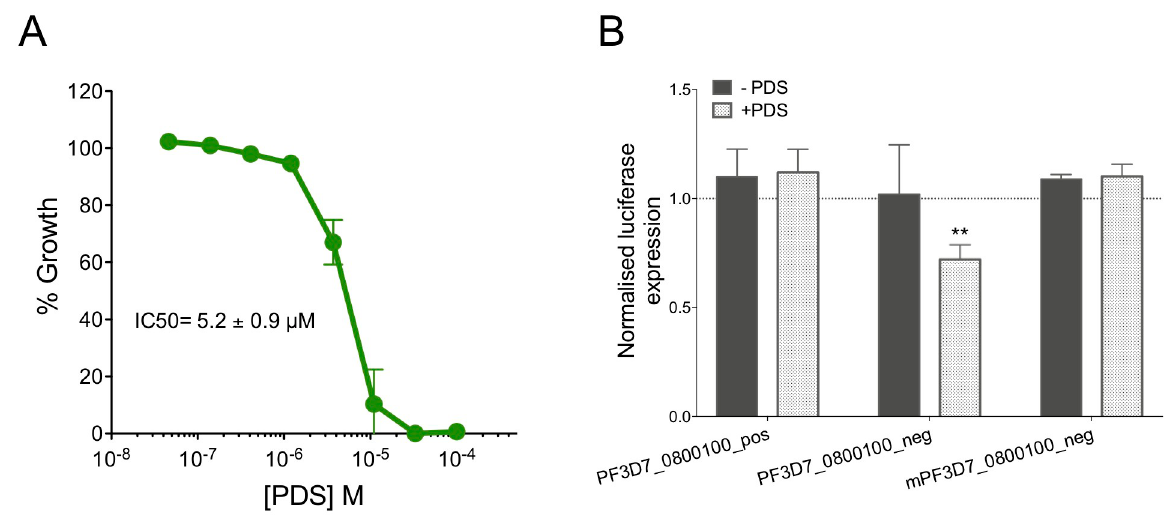
Fig 7. Transcriptional control of G4FS in var promoters. (A) Growth curve analysis and IC 50 determination of P . falciparum 3D7 strain treated with PDS using Desjardins experiment [62]. Error bars represent standard deviations of experiments done in triplicate. (B) Promoter-driven luciferase assay performed by transient transfection of P . falciparum at ring stage (dark grey bars) with plasmids that encode the luciferase gene under calmodulin gene promoter with the G4 sequence that was cloned upstream the promoter. Parasites were maintained for 48h before saponin-lysis and luciferase signal measurement. In parallel, parasites were treated with 1 μ M pyridostatin (PDS) (light grey bars). Results are the mean of three independent experiments (two-tailed t -test, �� p -value <